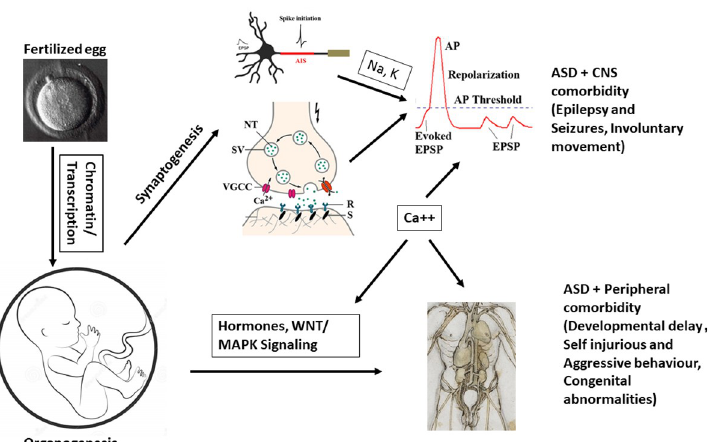
Fig 10. Working hypothesis of ASD. From fertilization to full development, mutations in chromatin modelling and transcription factors can contribute to altered developmental trajectory in brain formation, synaptogenesis, and organogenesis. Alterations in synaptic and ion channel genes may lead to perturbed action potentials and imbalance of E/I synapses that can contribute to the core ASD symptoms and CNS comorbidity such as epilepsy and motor functions. However, alterations in cellular, hormonal signalling and gene regulation can contribute to peripheral co- morbidities such as altered facial phenotypes and behaviour. Calcium signalling appears acting as a hub among the CNS and peripheral